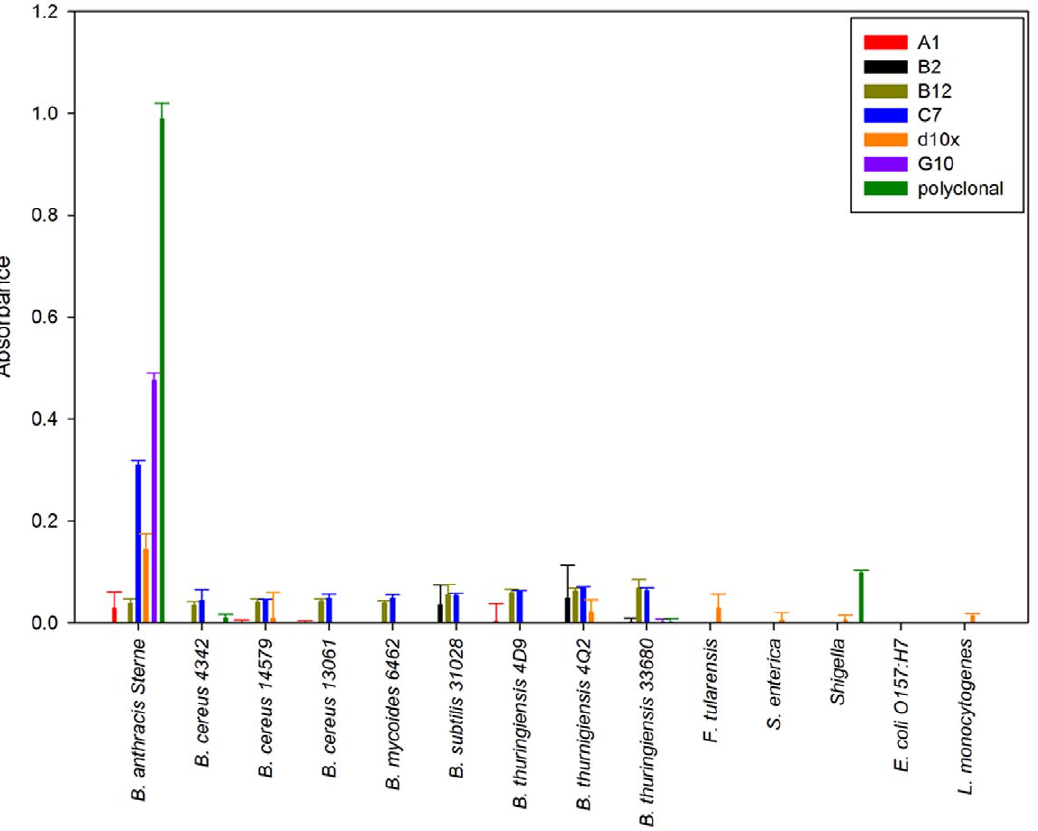
Figure 3. Specificity of sdAbs for whole bacteria. Bacteria were either grown overnight as live cultures or obtained from either CRP or KPL as killed material. Equivalent optical densities were immobilized to microtiter dishes for analysis of specificity using a direct binding ELISA.